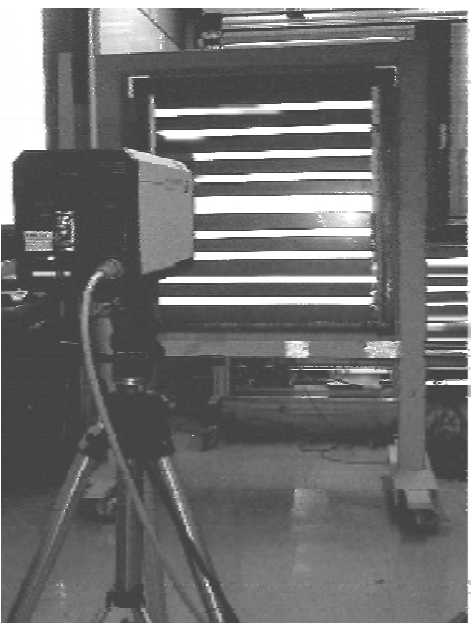
Fig. 3. Experimental set-up for measuring the vibrating velocity in the plate using scanning laser vibrometry